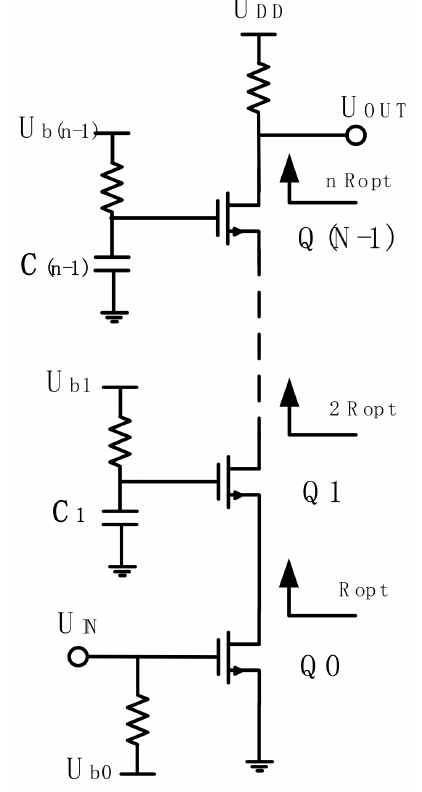
Figure 11. The n-layer stacked-FET amplifier circuit schematic